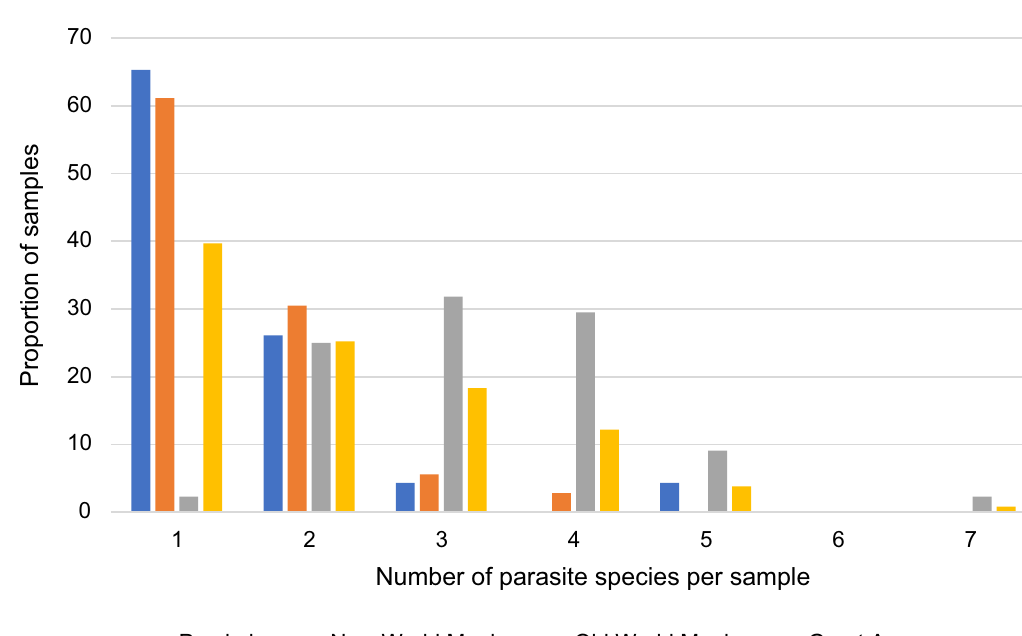
Figure 1. Distribution of multispecies parasitism in non-human primate groups.